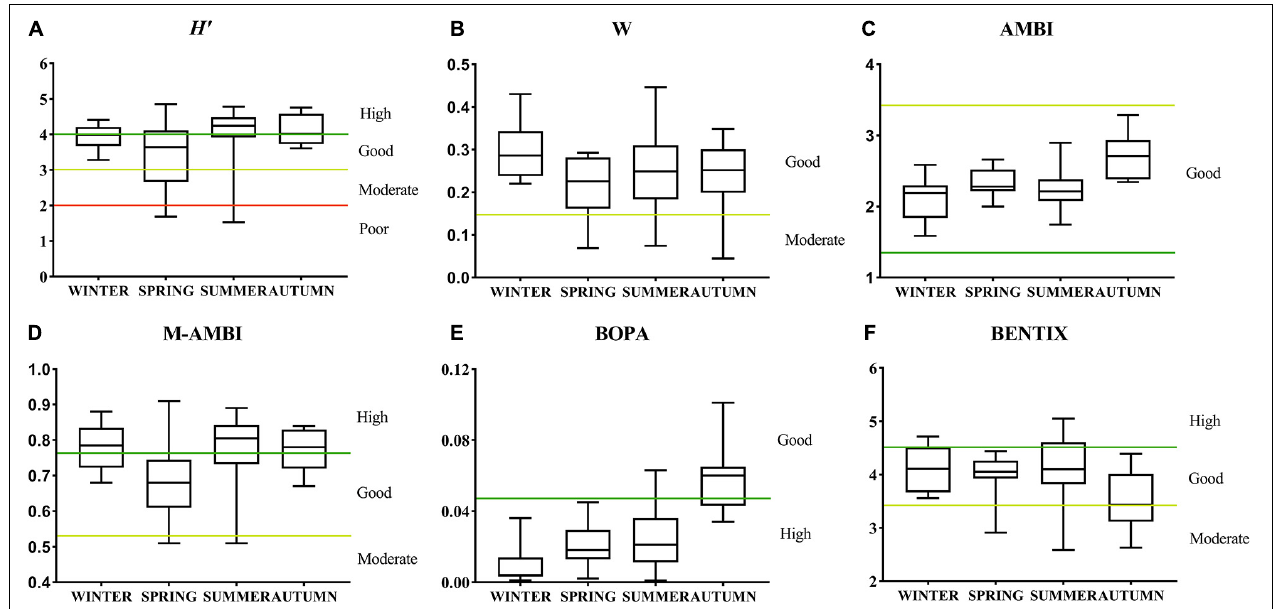
FIGURE 6 | Seasonal differences in the environmental assessment of different biological indices in Jiaozhou Bay. The label on the right axis (“Poor to High”) indicates ecological status. Values are medians (horizontal lines), the range between the 25th and 75th percentiles (boxes), and the minimum and maximum values. H (cid:48) (A) , W